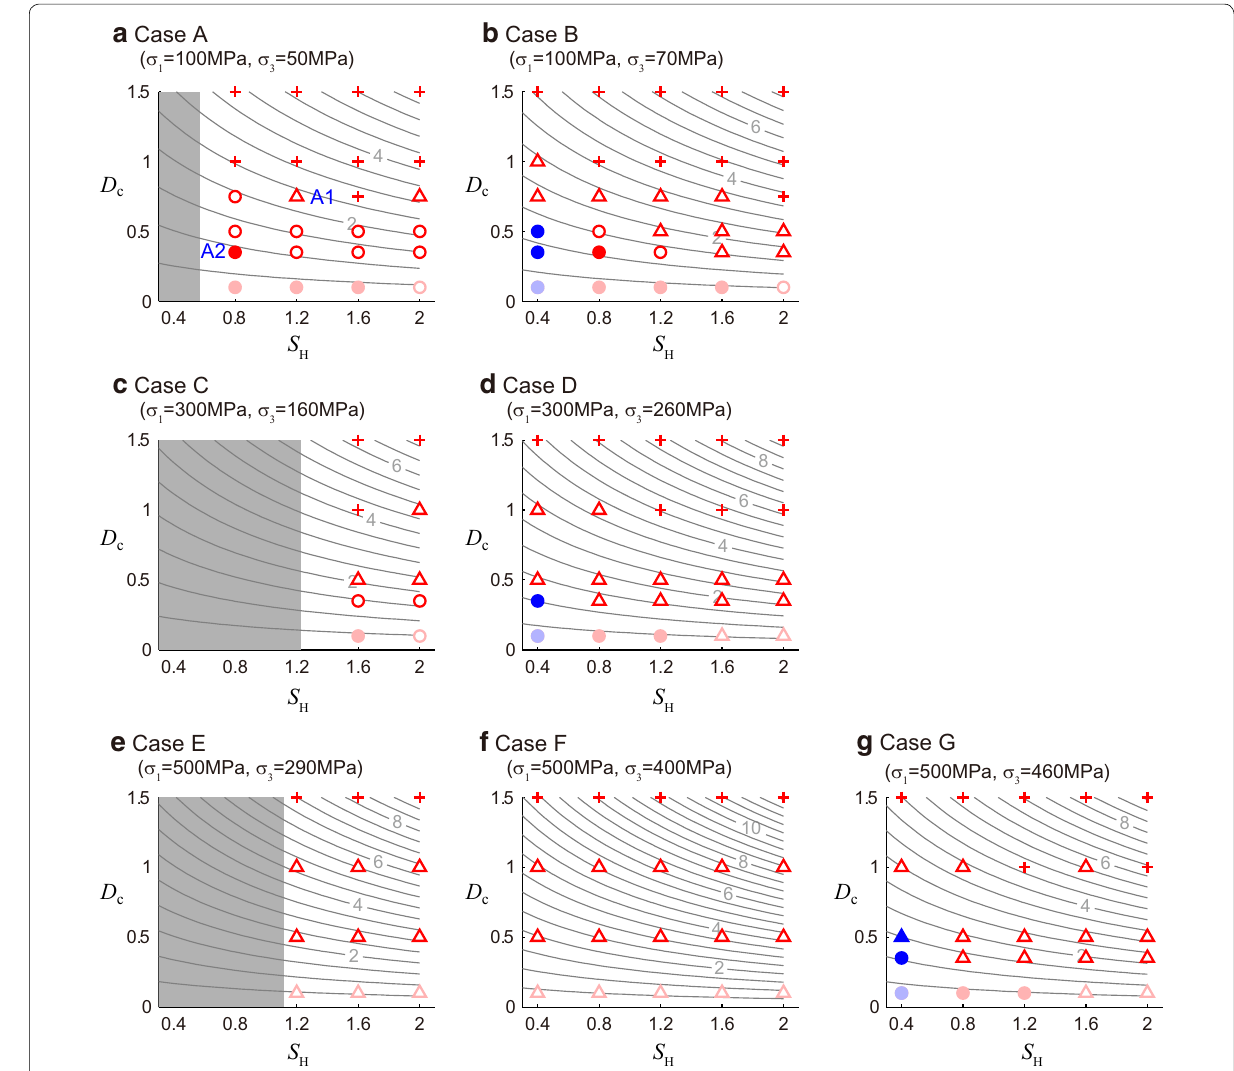
Fig. 7 Results of many numerical simulations with various friction parameters S H and D c . Circles indicate that a rupture propagated successfully. Triangles indicate that a rupture was initiated but terminated shortly. Crosses indicate that no rupture was initiated. A rupture started spontaneously from the high ΔCFS regions on the Hinagu fault without the artificial shear stress increase in the cases indicated by the solid symbols. Among these cases, the blue and light blue symbols indicate that the high ΔCFS triggered ruptures not only at the hypocenter of the main shock but also at a shallow part of the Hinagu fault. In the other cases, a rupture was forced to be initiated by artificially increasing shear stress. In the cases shown by the light red and light blue symbols, the cohesive zone may not be resolved. For small S H values indicated by gray, µ s is smaller than µ r = τ r in junction elements. Contours show the fracture energy G c integrated on the whole fault plane (unit is 10 15 Nm ), calculated by using σ 0 n values. In the computations, a non-planar fault is in the infinite medium (i.e., without a free surface). σ 1 is 100 MPa and σ 3 is a 50 MPa (case A) and b 70 MPa (case B), σ 1 is 300 MPa and σ 3 is c 160 MPa (case C) and d 260 MPa (case D), and σ 1 is 500 MPa and σ 3 is e 290 MPa (case E), f 400 MPa (case F), and